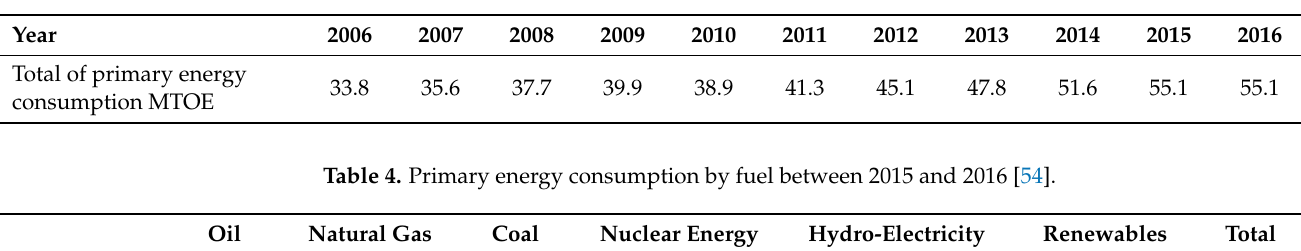
Table 3. Primary energy consumption in the period 2006–2016 [54].